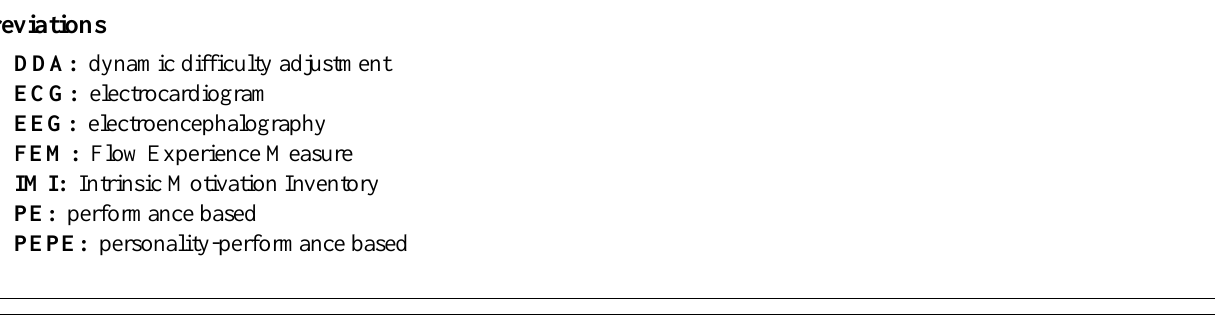
Flom P, Cassell D. Stopping stepwise: Why stepwise and similar selection methods are bad, and what you should use. In: Maryland URL: